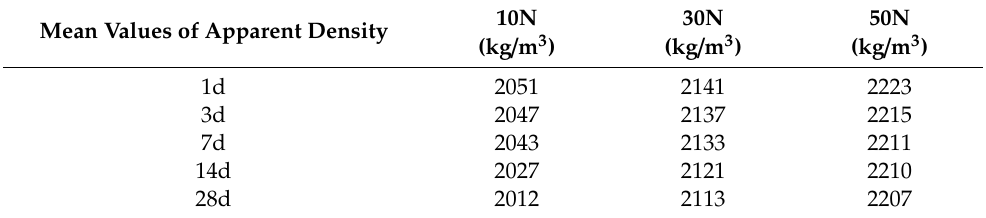
Table 7. Apparent densities of geopolymer mortars 10N, 30N, and 50N at different ages.